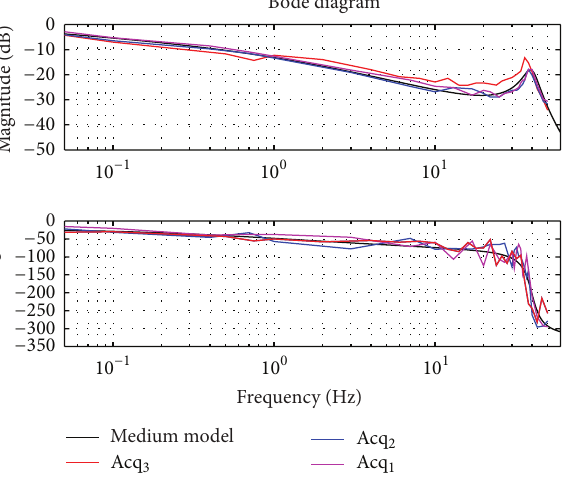
Figure 10: Magnitude and phase of the model on Acq 3 data via simplex method.